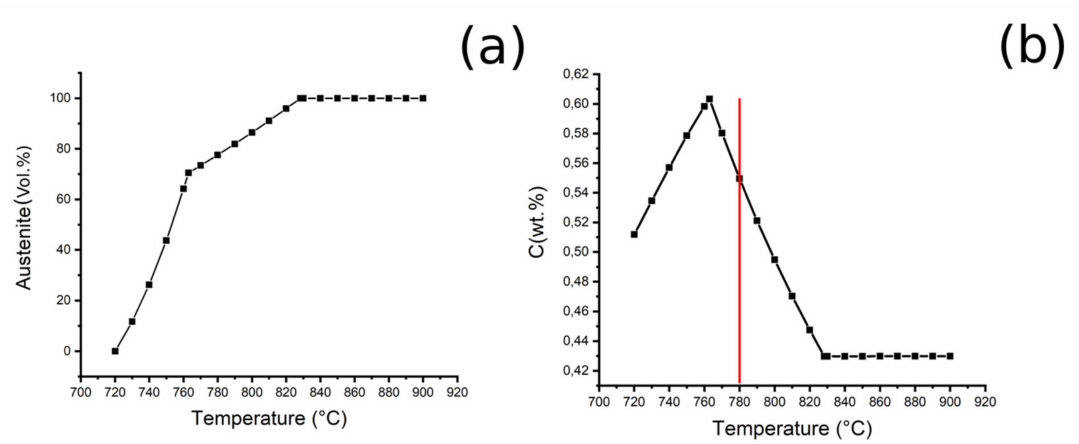
Figure 1. Volume percentage of austenite ( a ) and carbon content ( b ) as a function of temperature during austenitization. The red line in ( b ) indicates intercritical annealing condition.